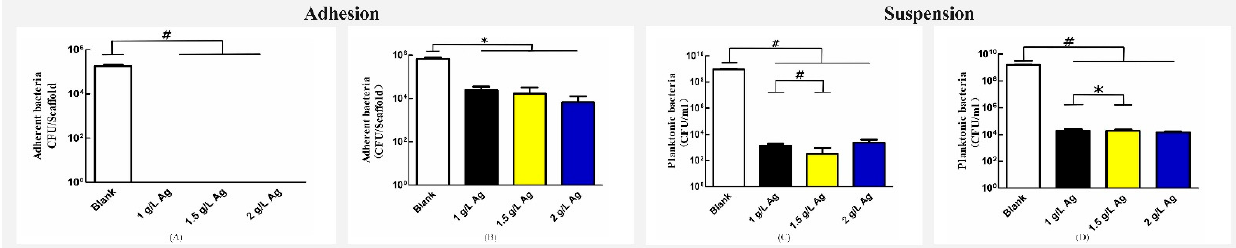
Figure 4. The adherent and planktonic bacterial activity against an inoculum of 1.5 × 10 5 cells after 24 h. ( A , C ) represent the activities of Staphylococcus aureus ( S. aureus ); ( B , D ) represent the activities of Escherichia coli ( E. coli ). * p < 0.05; # p < 0.01.